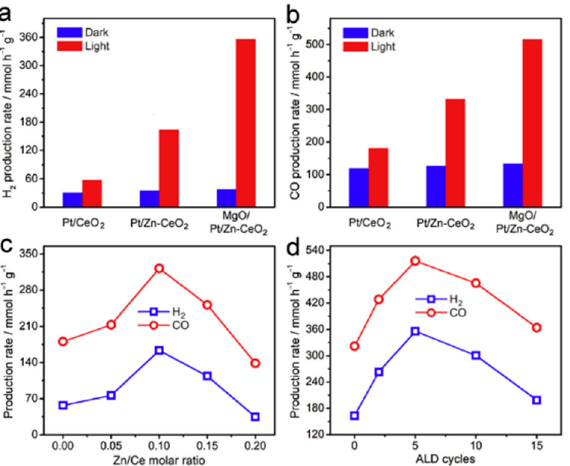
Figure 24. Photocatalytic activity of the material that is described in Figure 24 and the references. ( a ) H 2 and ( b ) CO production rates at 600 °C in the dark and light irradiated condition. Molar ratio optimization of Zn-Ce is shown in ( c ), and the time of ALD cycles optimization is shown in ( d ). Copyright (2020), reprinted from [46] with permission from Elsevier. ALD: atomic layer deposi- tion.